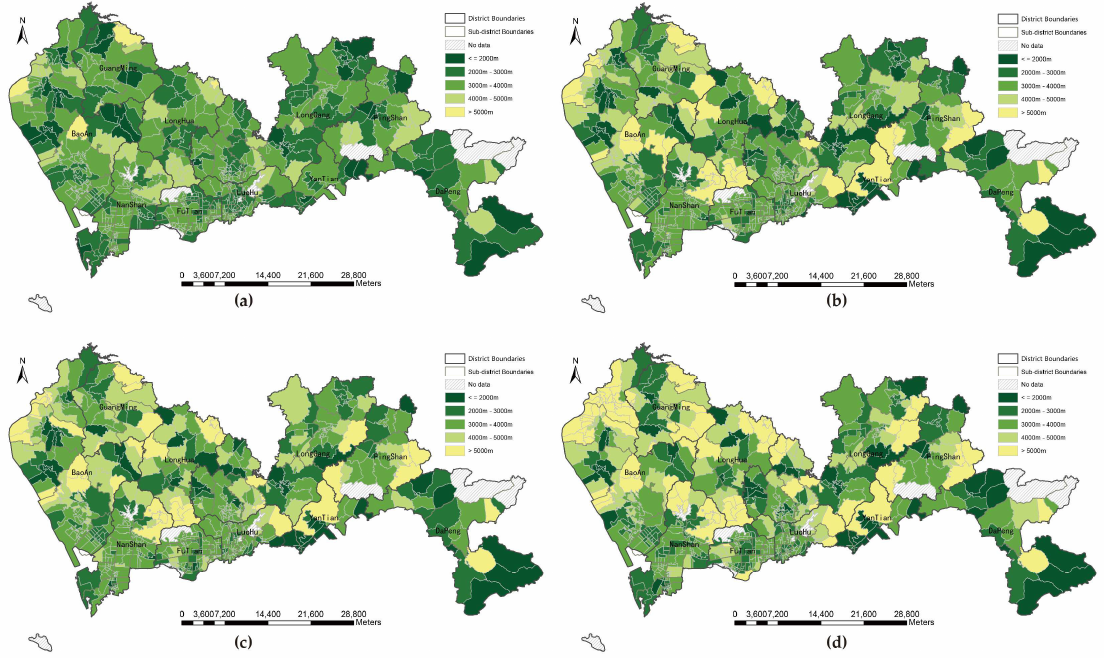
Figure 4. Proximity to city parks in threshold of 5 km by four types of distance: ( a ) Euclidean distance; ( b ) walking distance; ( c ) bicycling distance; ( d ) driving